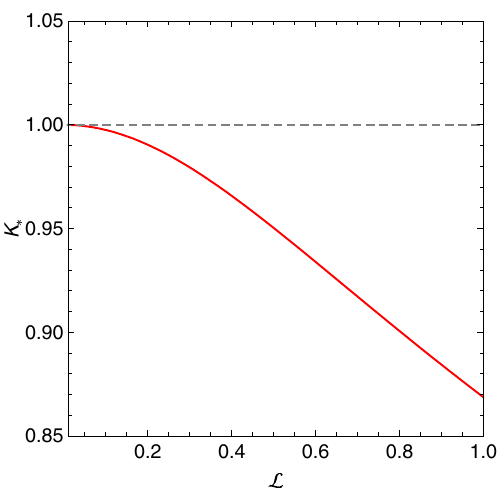
Figure 2. The dimensionless critical wave-number (34) as a function of the dimensionless intrinsic length scale parameter